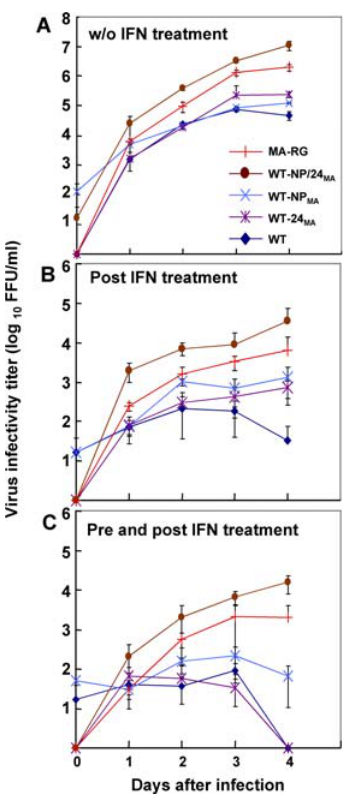
Figure 4. Effect of Murine Type I IFNs on Recombinant Virus Replication in Mouse Macrophages RAW 264.7 cells (mouse peritoneal macrophage-derived cell line) were infected with a multiplicity of infection of 0.05. Cells were untreated (A), treated with murine IFN- a / b (500 units/ml) 2 h postinfection (B), or treated with murine IFN- a / b (500 units/ml) 12 h prior to and again 2 h after virus adsorption (C). Supernatants were collected on days 0, 1, 2, 3, and 4 postinfection and titrated by use of a focus-forming unit assay in Vero E6 cells [36]. DOI: